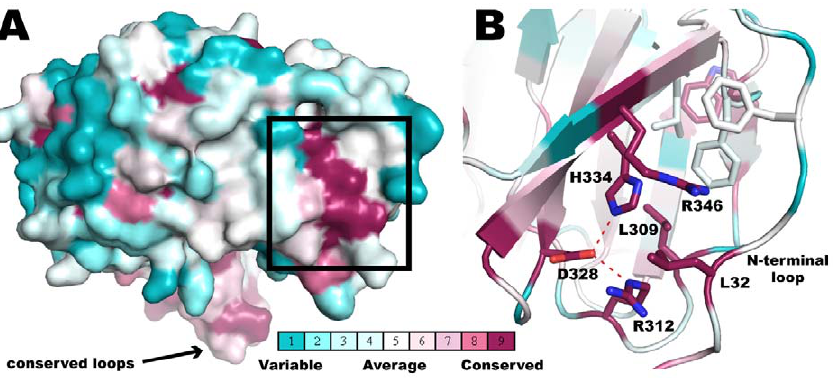
Figure 6. BamB Surface Residue Conservation Analysis. 335 BamB sequences were subjected to Consurf analysis to create conservations scores (see text for details). The conservation is color coded as follows: conservation scores are segregated into 9 discrete bins, such that bin 1 contains the most rapidly evolving residues (most variable) and is colored blue; bin 5 contains residues with average rate of evolution (colored white); and bin 9 has the most conserved residues and is colored dark purple. (A) Side view of a surface representation of BamB displaying a patch of conserved residues on the side of the propeller. (D) Close up of the region framed in (C) detailing the interactions at the groove between blades 6 and 7 and the N-terminal